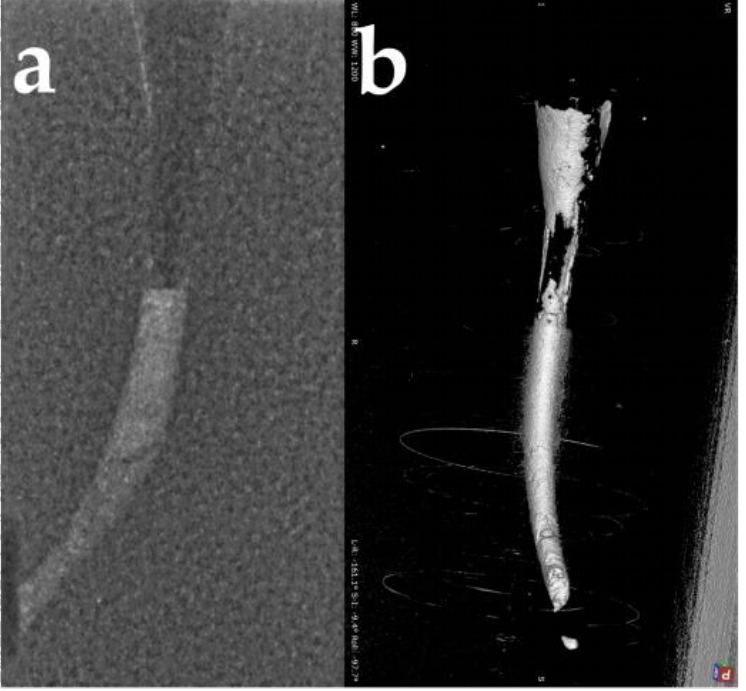
Figure 13. Determination of the sealing quality in endo training blocks. ( a ) X-ray images; ( b ) µCT images of obturated endo training blocks.